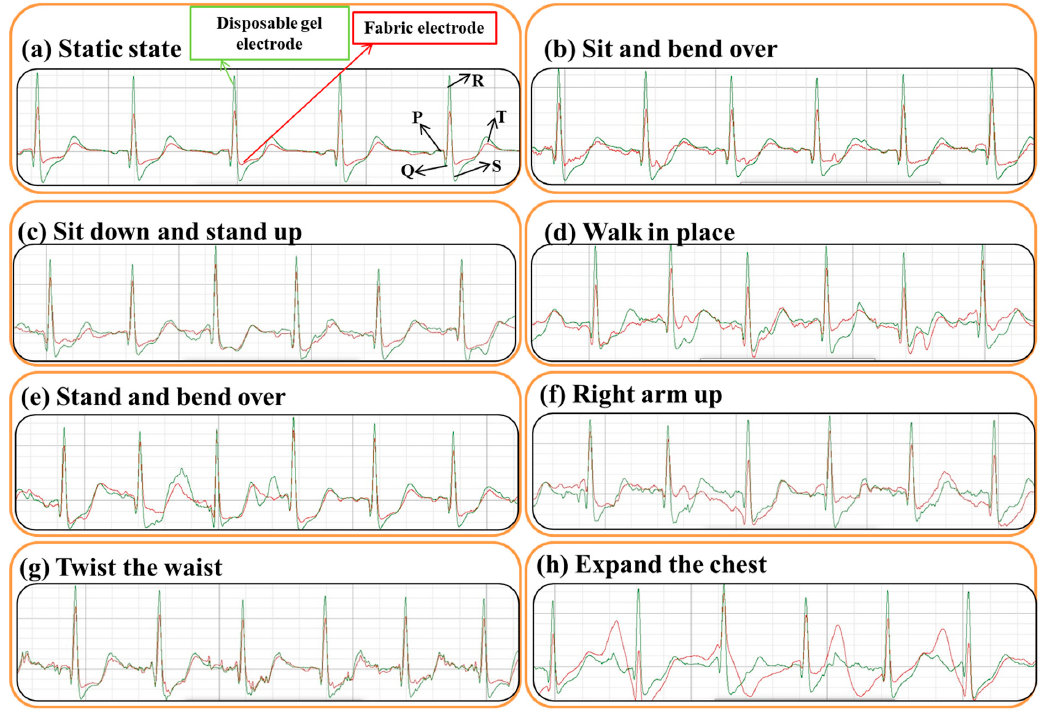
Figure 9. Polyester fabric electrodes and disposable gel electrodes monitor ECG in different states of the human body.